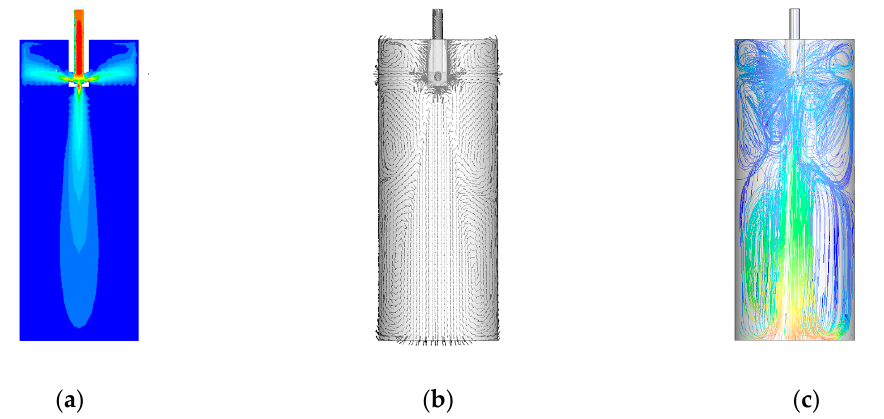
Figure 4. The distribution of flow field of molten steel in mold. ( a ) Contour; ( b ) Vector graph; ( c ) Streamline graph.